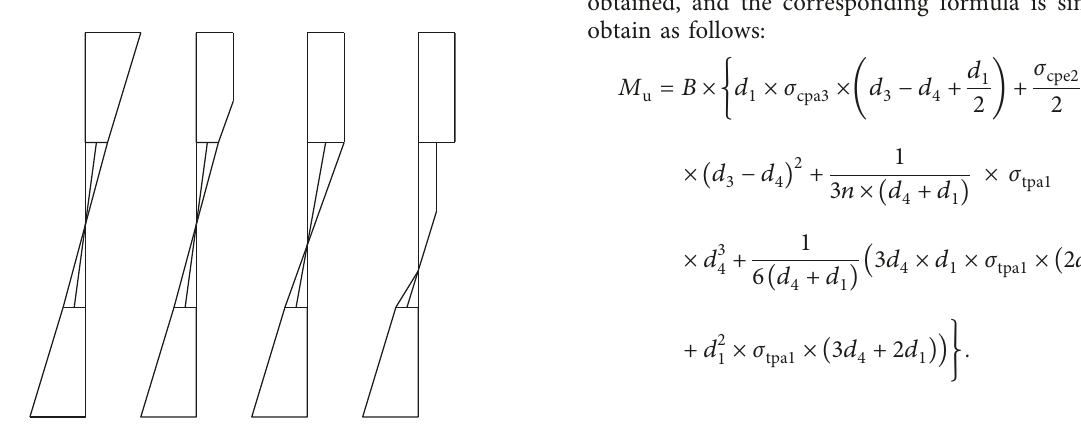
Figure 7: Stress evolution on the cross section in the CLT of three layers.